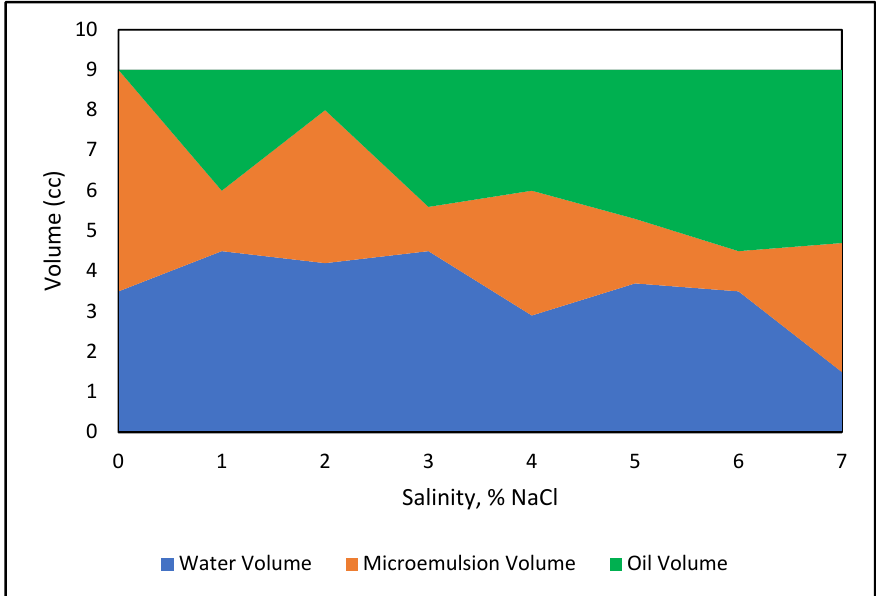
Figure 8. Phase diagram of 0.5% APG, crude oil, and 0–7% NaCl mixture.